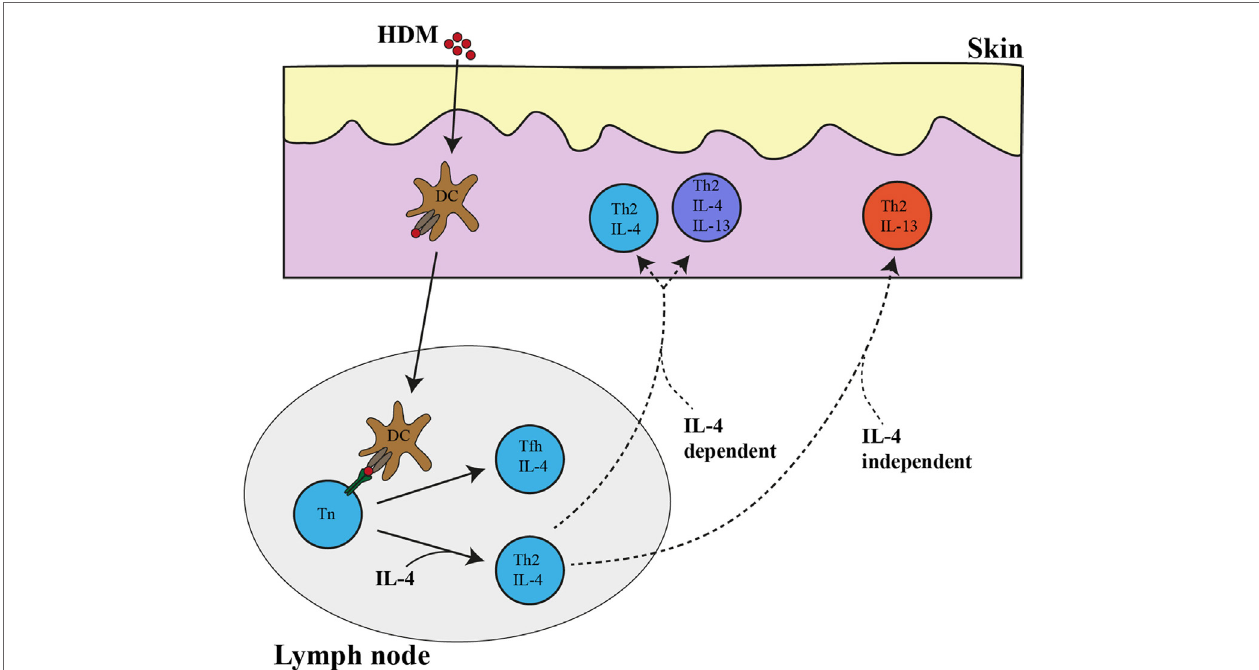
FigUre 6 | IL-4- and IL-13-expressing Th2 subsets in the lymph node and ear tissue after allergen priming. Following house dust mite (HDM) priming in the ear skin, dendritic cells take up allergen and transport it to the ear draining lymph node where they present it to naïve CD4 T cells. Naïve CD4 T cells differentiate into either (i) IL-4-expressing Th2 cells in a process that is partially dependent on IL-4 or (ii) IL-4 independent IL-4-expressing T follicular helper (Tfh) cells. IL-4 single- positive CD4 T cell and IL-4/IL-13 double-positive-expressing CD4 T cell subsets in the skin tissue are very dependent on IL-4 while IL-13 single-positive-expressing Th2 cells are independent of IL-4. The broken line represent the as of yet unproven but potential link between the lymph node Th2 cells and those in the